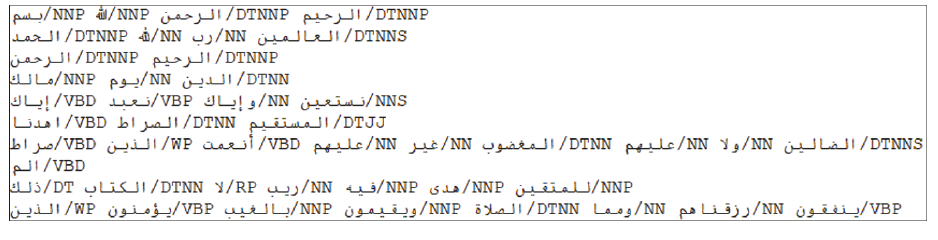
Figure 3: A part of the Stanford tagger output.